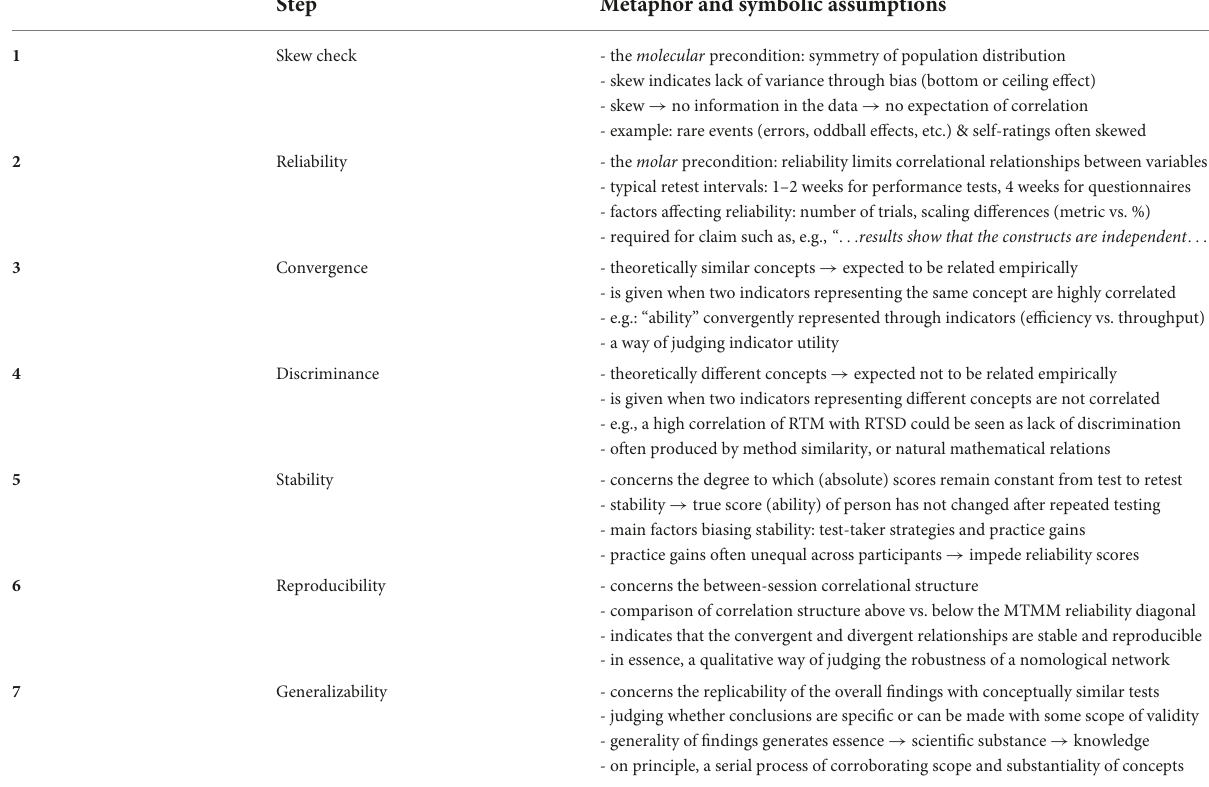
TABLE 1 A brief guide to understanding the logic underlying the Multitrait-multimethod (MTMM) approach to individual differences in multitasking. Step Metaphor and symbolic